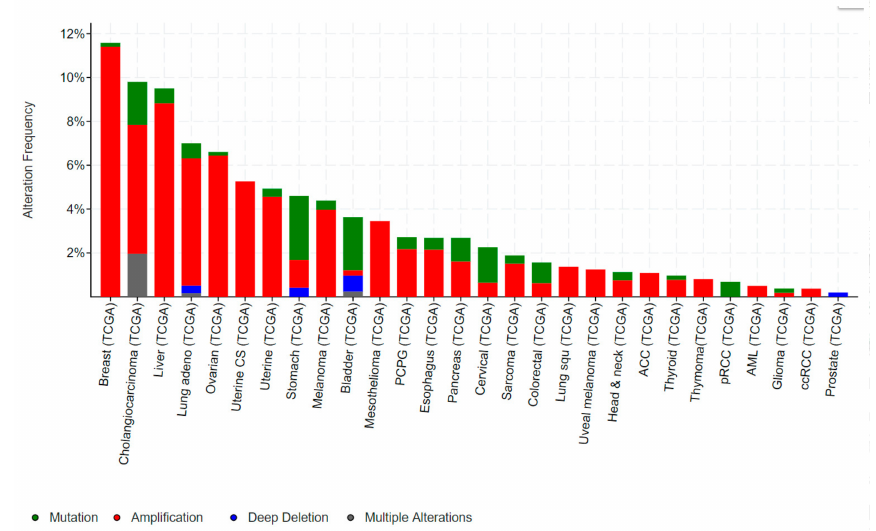
Figure 3. Frequency of genomic alterations in ELF3 in human cancers. Data obtained from cancer bioportal [19,20]. Only showing cancers in which >50 cases were